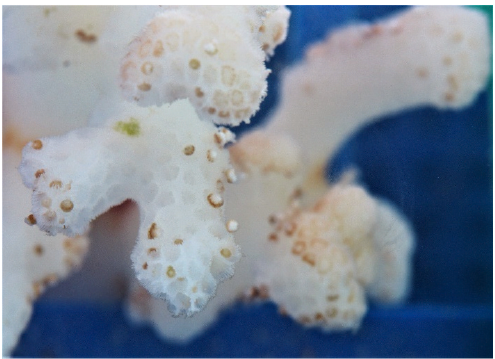
Figure 1. Photographs of polyps dropping off the skeleton of Pocillopora damicornis. Macrophotograph of polyps, having withdrawn from the connective coenosarc, dropping off the skeleton of the fragments of Pocillopora damicornis . Photograph taken with an Olympus Stylus Tough TG-4.